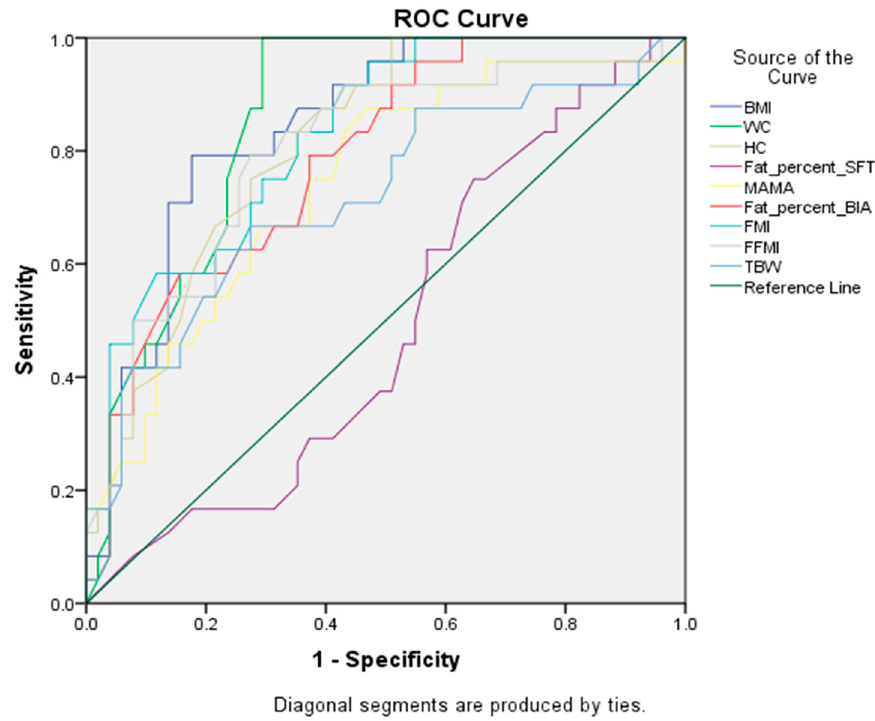
Figure 2. Receiver Operating Characteristics (ROC) curve showing sensitivity and specificity of BMI, WC, HC, BFP-SFT, MAMA, BFP, FMI, FFMI, TBW at different cutoff points in addition to the area under the curve (AUC). Table 3. Sensitivity and Specificity of BMI, WC and anthropometric measures, BIA tests, and their cut-off points for diagnosing Metabolic Syndrome.